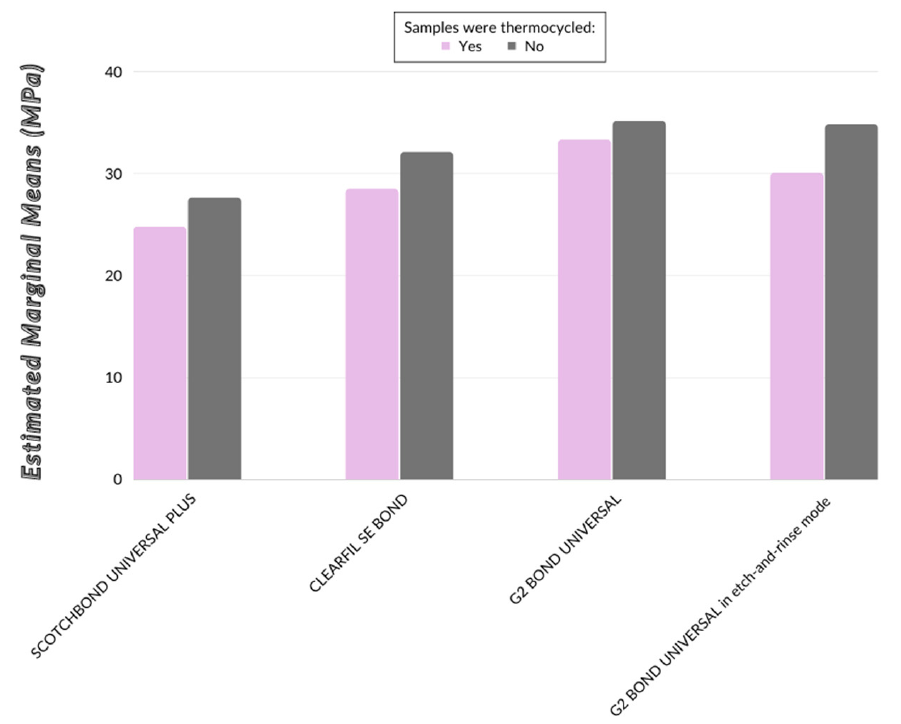
Figure 3. Estimated marginal means of SBS of the tested adhesives. Table 3. Mean ± standard deviation of SBS of the tested adhesive application mode and aging